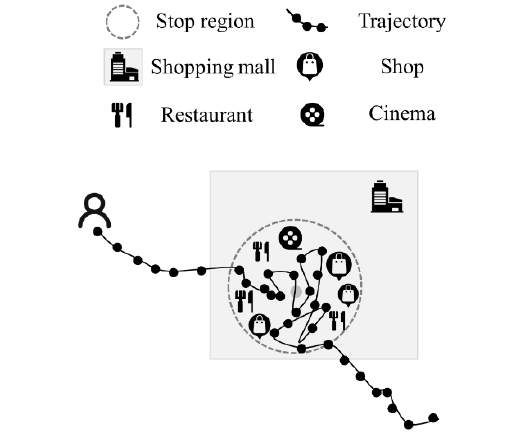
Figure 1 . Uncertain visited places in real trajectories. One stop may match multiple different places.